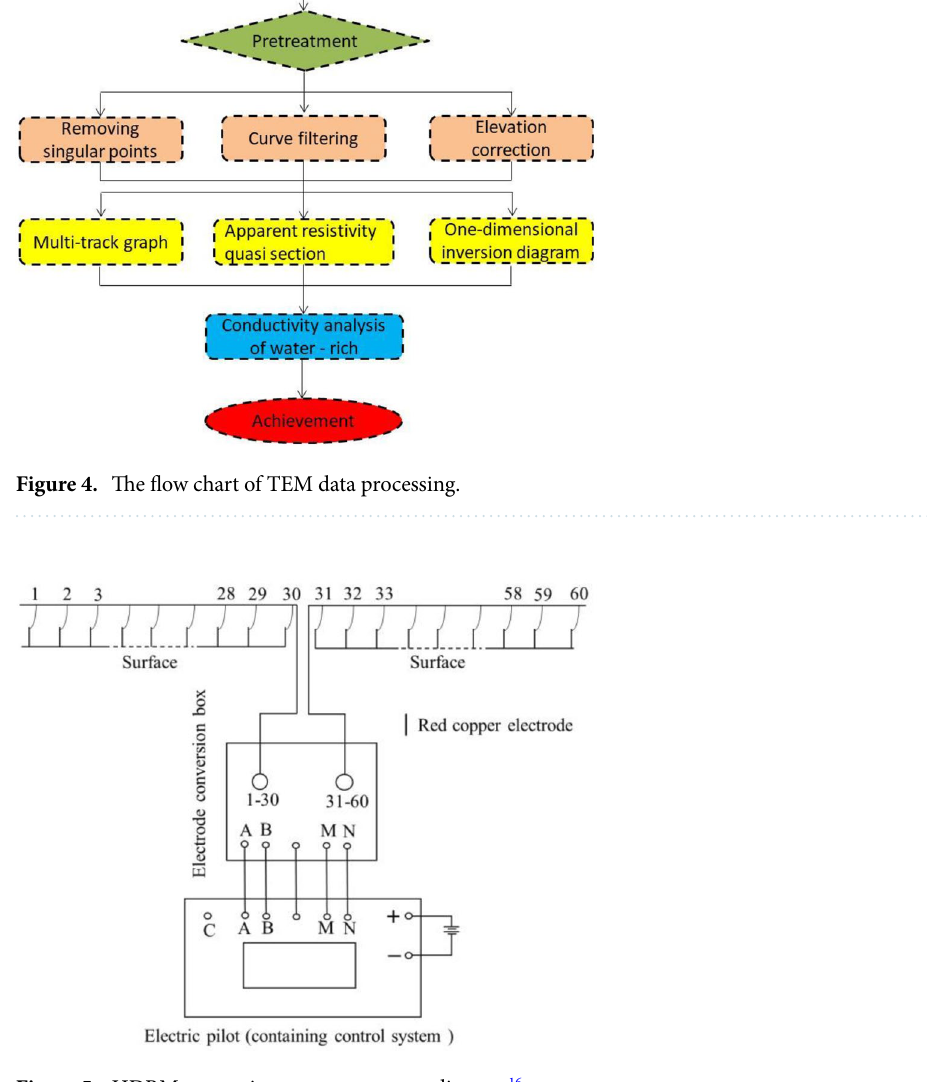
Figure 5. HDRM measuring system structure diagram 16